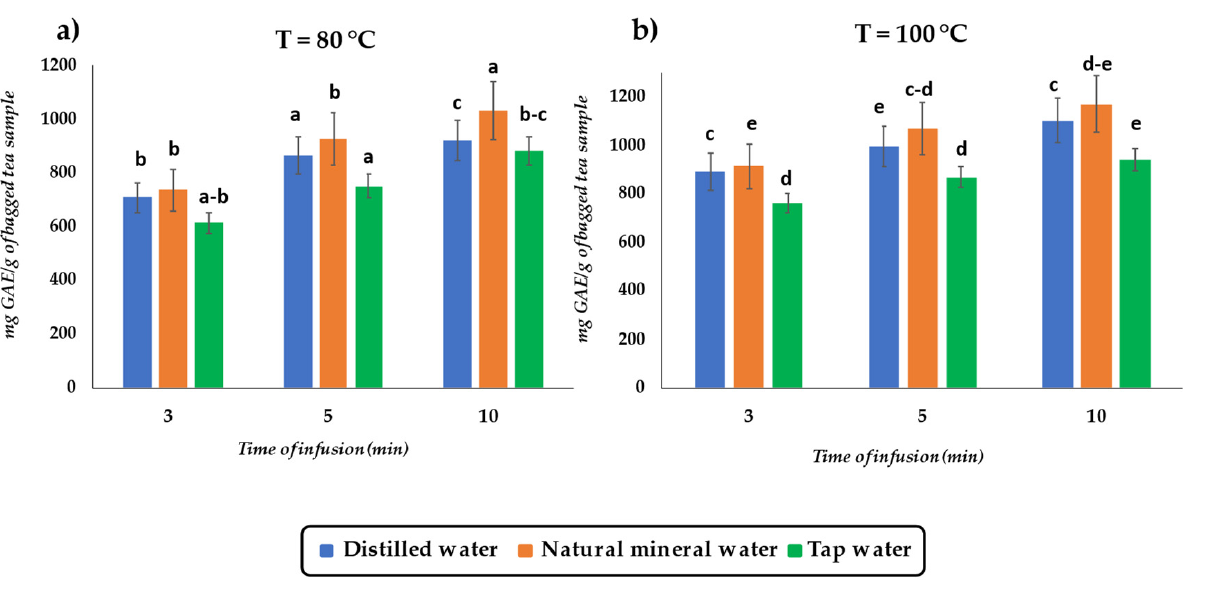
Figure 4. Total phenolic content (TPC) in black tea samples (mg GAE/g). ( a ) TPC for black tea infusion at T = 80 ◦ C for different infusion times and different types of water; ( b ) TPC for black tea infusion at T = 100 ◦ C for different infusion time and different types of water. Error bars are ± standard deviation. Same letters indicate a significant difference according to the ANOVA test ( p < 0.05).